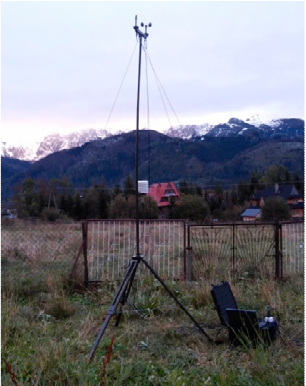
Figure 4. AGAT20L weather station.